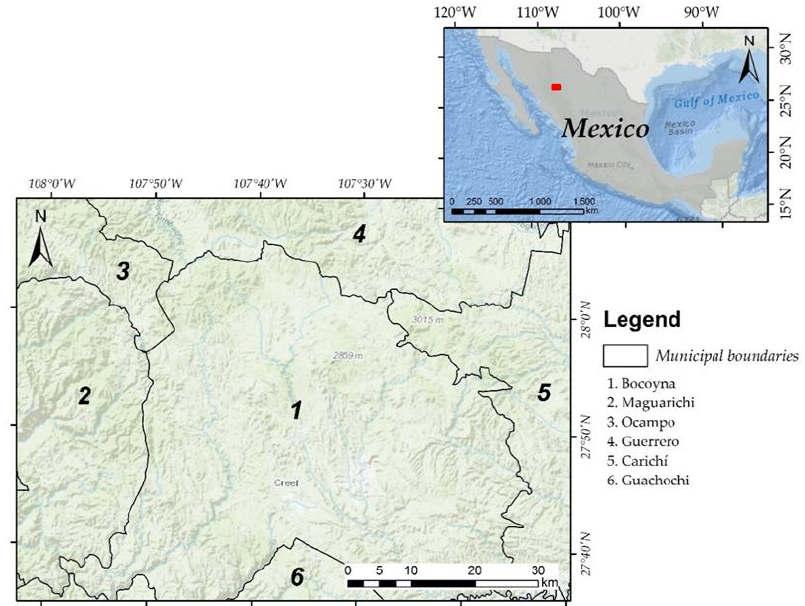
Figure 1. Study area: a portion of the temperate forest of northern Mexico.